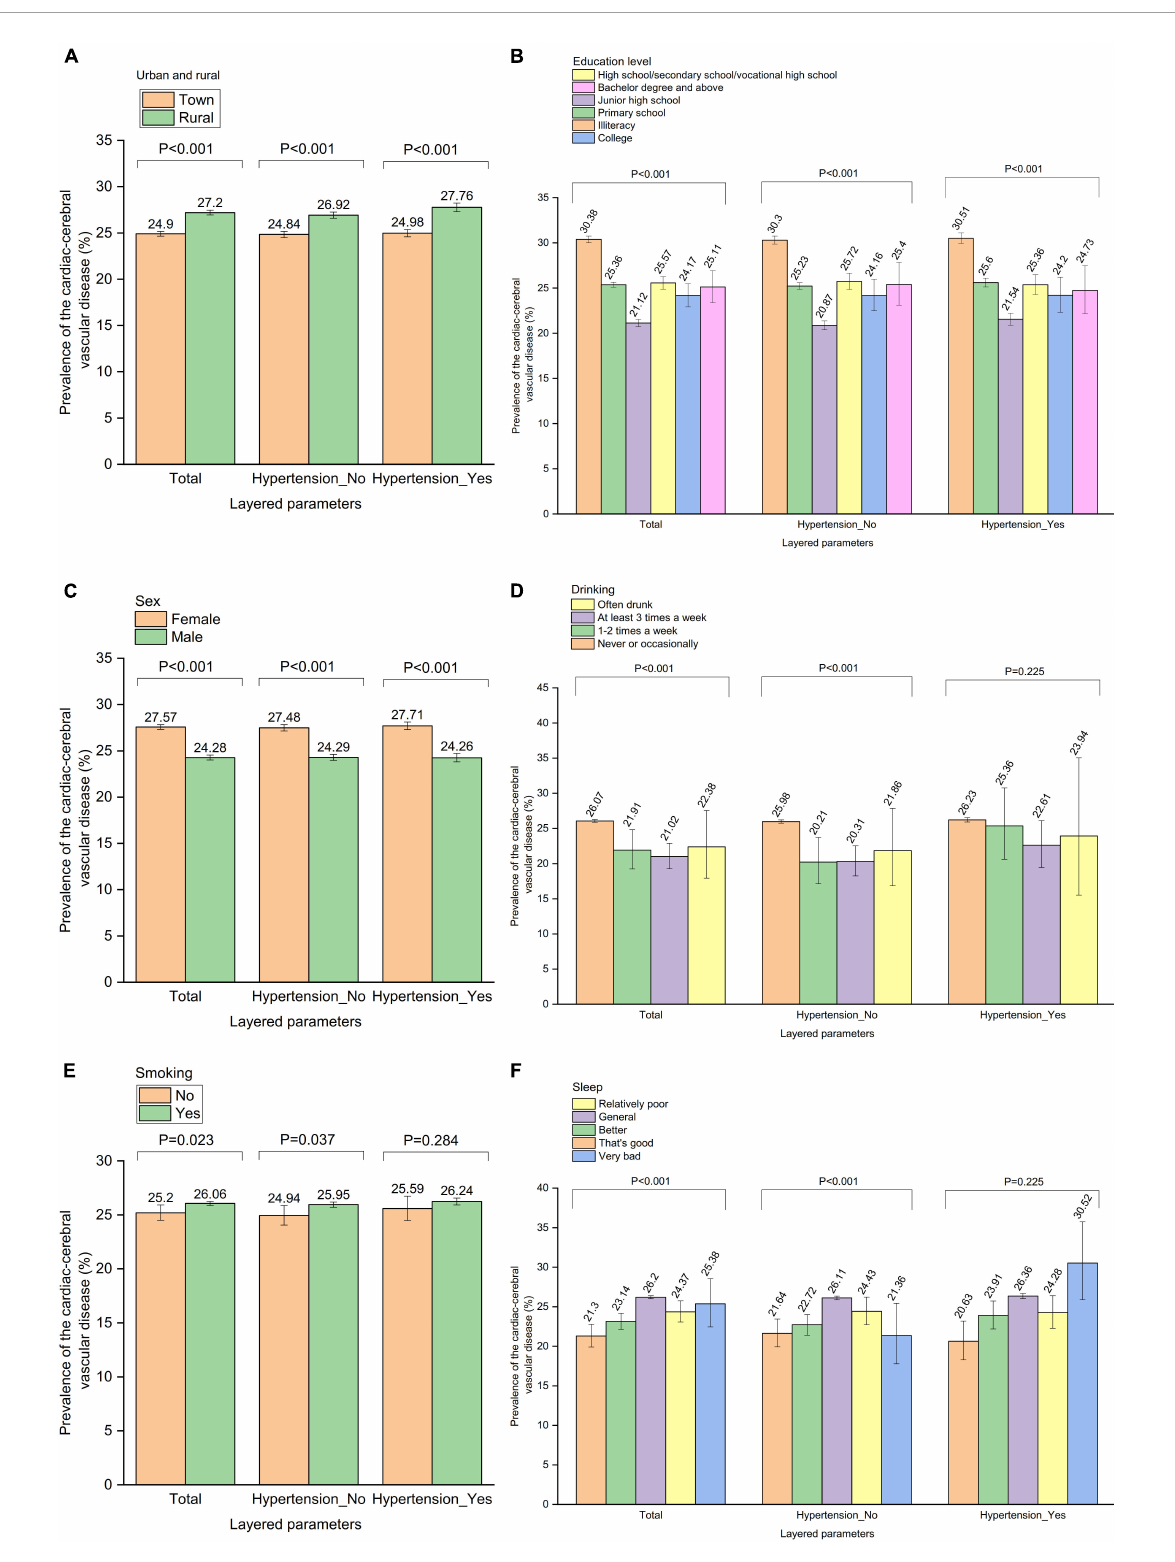
FIGURE5 The relationship between parameters and cardiac-cerebral vascular disease was further analyzed by “hypertension” stratification. Prevalence of the cardiac-cerebral vascular disease by (A) “Urban and rural” stratification, (B) “Education level” stratification, (C) “Sex” stratification, (D) “Drinking” stratification, (E) “Smoking” stratification, (F) “Sleep”